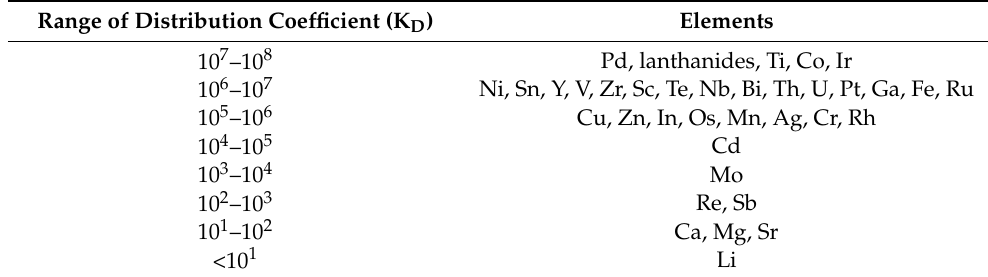
Table 2. The range of distribution coefficient (K D ) of different elements on the amidoxime–carboxylate containing polymer fiber in Sequim Bay seawater after 56 days of exposure at 20 ◦